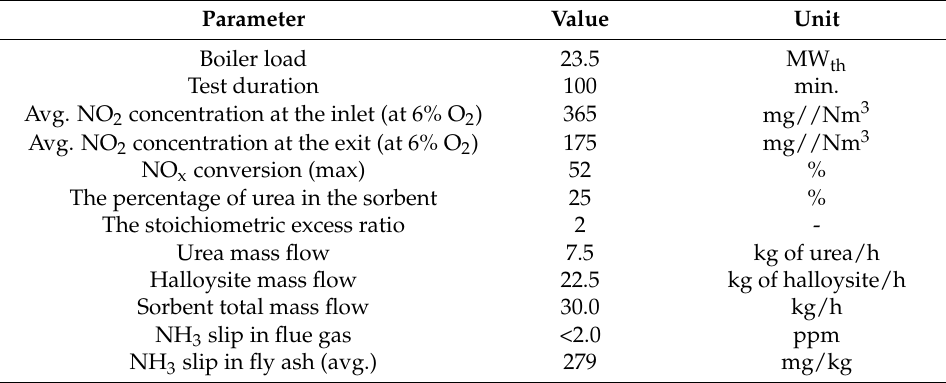
Table 2. Operation parameters for HALKORNOKS technology reference test.